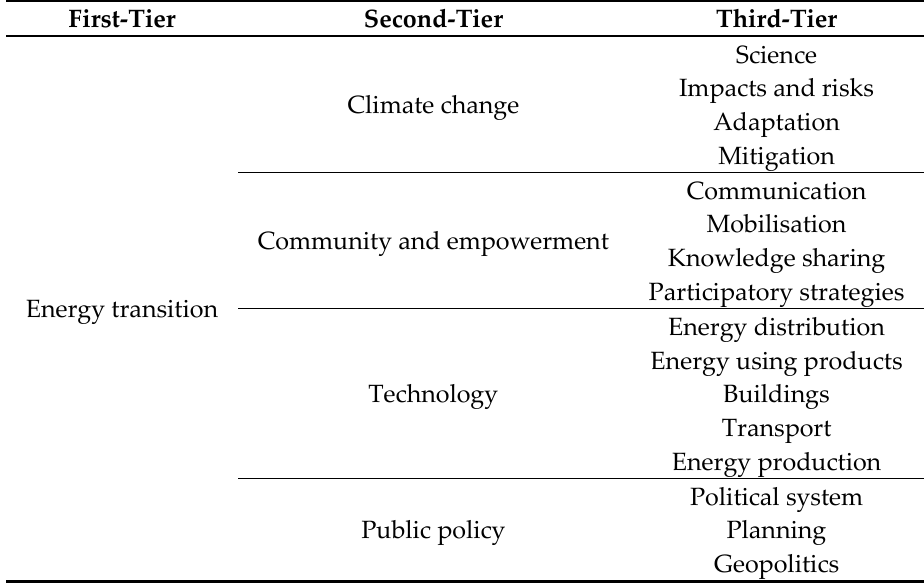
Table A1. Knowledge content–tiered